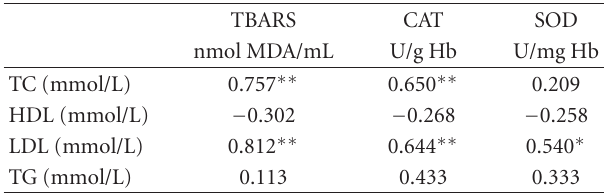
Table 2: Correlation analyses between oxidative stress biomarkers and lipid parameters in subclinical hypothyroidism and controls